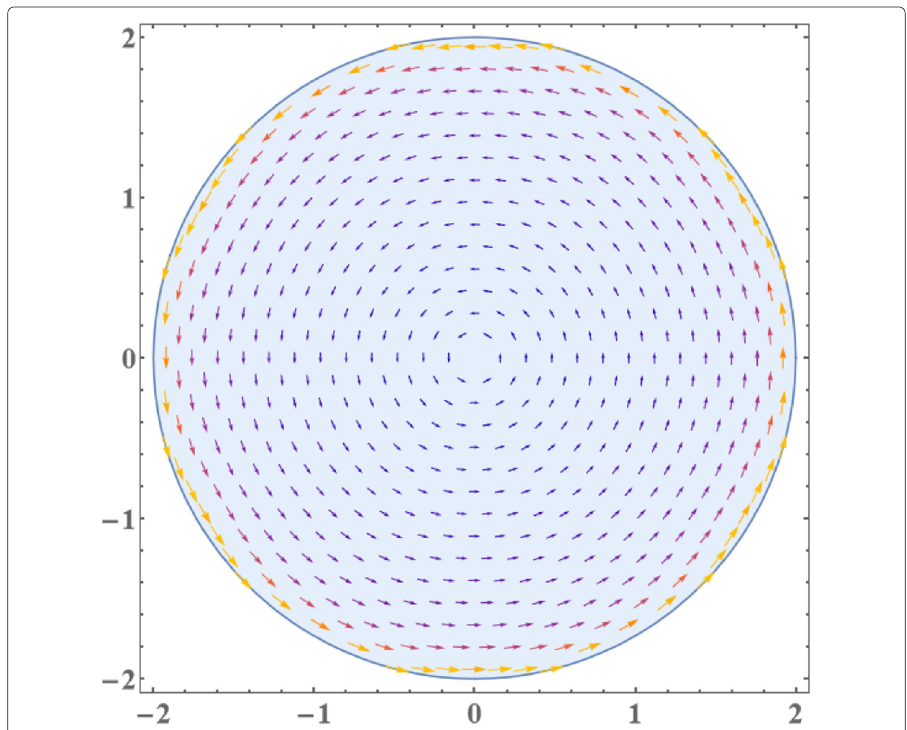
Fig. 3 GND vector field ρ ( 0,1 ) as induced by positively oriented circles of radius R = 1. Length and color of the arrows indicate the magnitude of the vectors, qualitatively. Note that the magnitude diverges at r = 2